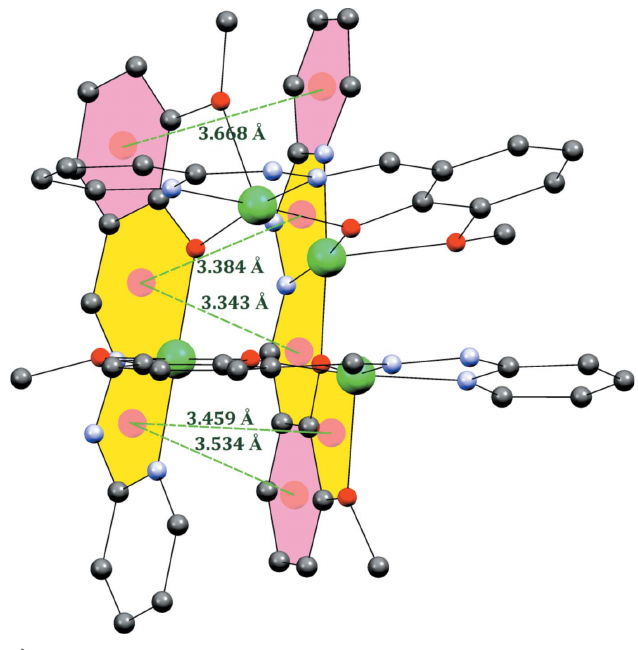
Figure 4 Diagram showing the (cid:5) – (cid:5) stacking interactions (drawn as dashed lines) observed in the